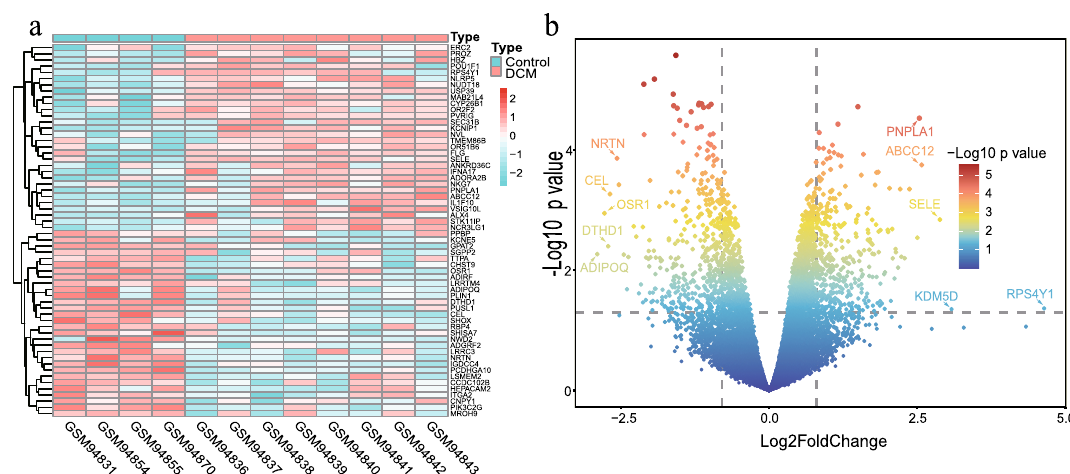
Figure 2. DEGs differential analysis of GSE4172 dataset. ( a ) Heatmap of DEGs in GSE4172 dataset (n = 60, p < 0.05, |log2 FoldChange|≥ 0.8). ( b ) Asymptotic volcano map of gene expression in the GSE4172 dataset. The two vertical lines indicated gene expression ploidy changes > 0.8 and < -0.8, respectively, and the horizontal line indicated a p value of 0.05. The color of the dots represented the level of the p value. The top 10 significantly expressed genes among the DEGs were labeled on the